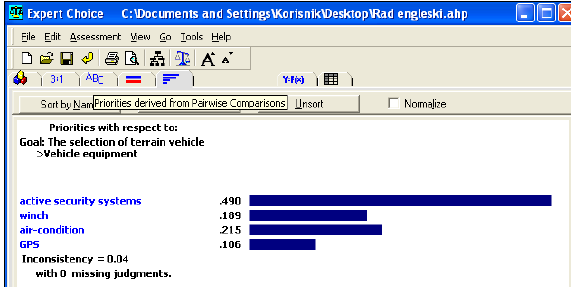
Figure 8. Vehicle equipment